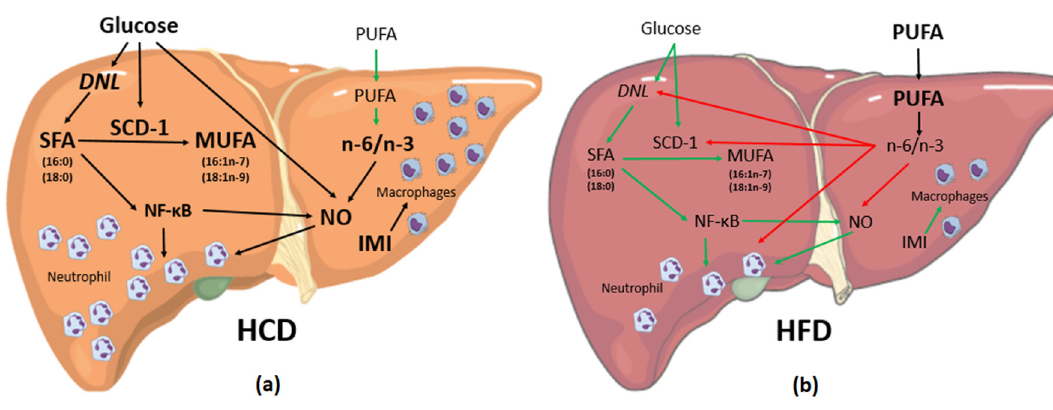
Figure 1. Summary of the results in livers from mice fed with either high carbohydrate diet (HCD) or high fat diet (HFD). Bold words indicate higher availability in comparison with the other group; black arrows indicate strong stimulation; green arrows indicate weak stimulation; red arrows represent inhibition. The HCD ( a ) generates glucose in excess that reaches the liver at high quantities and stimulates DNL and SCD ‐ 1 activity. This stimulation leads to production of high quantities of SFAs and MUFAs. SFA, especially 16:0, activates NF ‐κ B that increases NO production and tissue neutrophil infiltration indirectly. In addition, low quantities of n ‐ 3 PUFA and increased n ‐ 6/ n ‐ 3 PUFA ratio, prompt inflammation; HFD mice ( b ) had lower FA accumulation and lower n ‐ 6/ n ‐ 3 PUFA ratio in the liver that is well known as an anti ‐ inflammatory condition. Low n ‐ 6/ n ‐ 3 PUFA ratio inhibits DNL, reduces SCD ‐ 1 and NF ‐κ B activities and results in low lipid accumulation. Abbreviations: DNL, de novo lipogenesis; SCD ‐ 1, stearoyl CoA desaturase ‐ 1; SFA, saturated fatty acids; MUFAs, monounsaturated fatty acids; PUFAs, polyunsaturated fatty acids; NF ‐κ B, nuclear factor kappa B; NO, nitric oxide; IMI: inflammatory marker index.